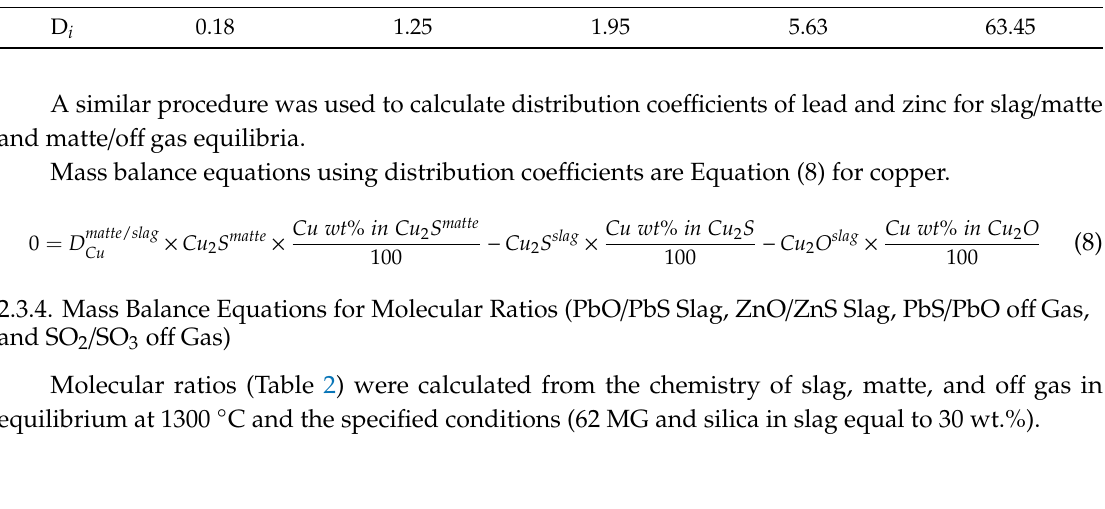
Table 1. Distribution coe ffi cients calculated with FactSage ™ for matte (MG 62) in equilibrium with slag (29 wt.% SiO 2 in slag) at 1300 ◦ C. Element i Pb Slag /